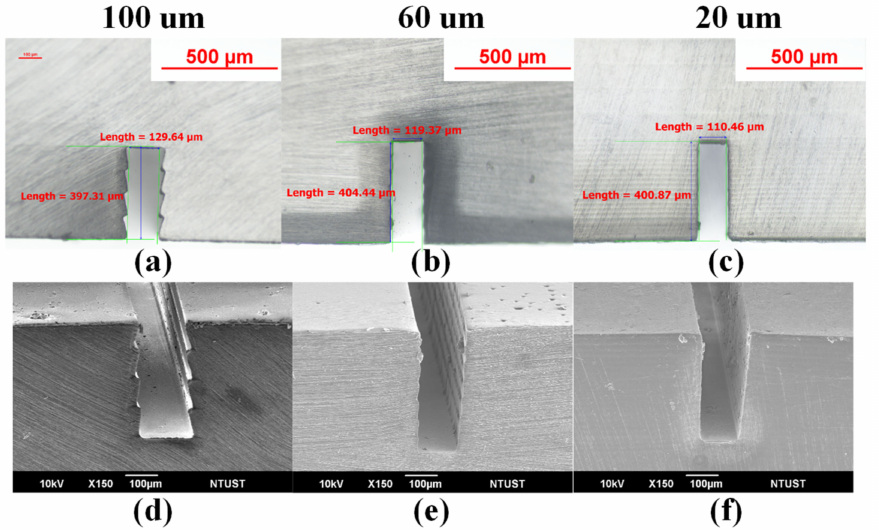
Figure 4. ( a – c ) Cross-sections with measurements obtained using a tool microscope; ( d – f ) SEM cross-sections corresponding to printing thicknesses of 100, 60, and 20 µ m,